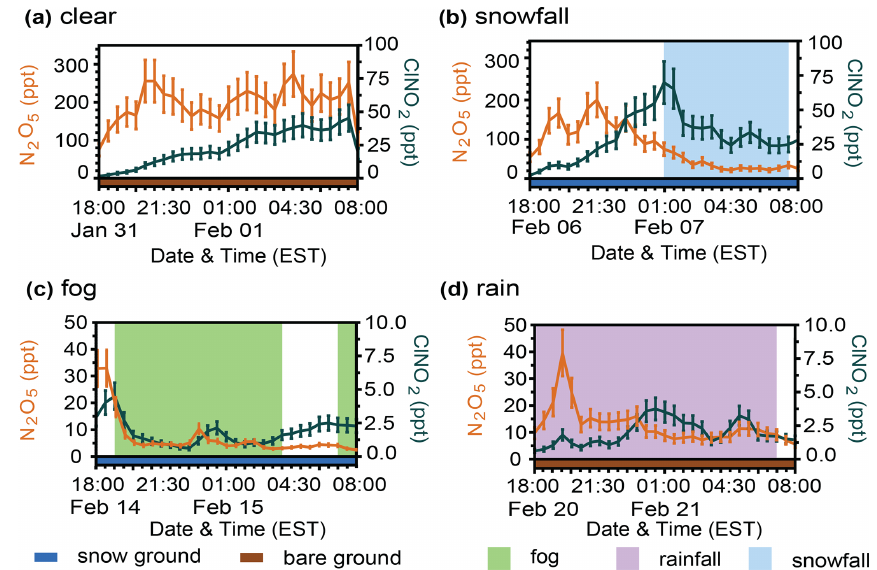
Figure 3. Four example case study periods are shown, corresponding to (a) clear conditions, (b) snowfall, (c) fog, and (d) rainfall. The 30min averaged abundances of N 2 O 5 (orange) and ClNO 2 (dark blue) are displayed for each case. Error bars represent propagated uncertainties. The shading below the x axis represents ground cover – snow (blue) or bare ground